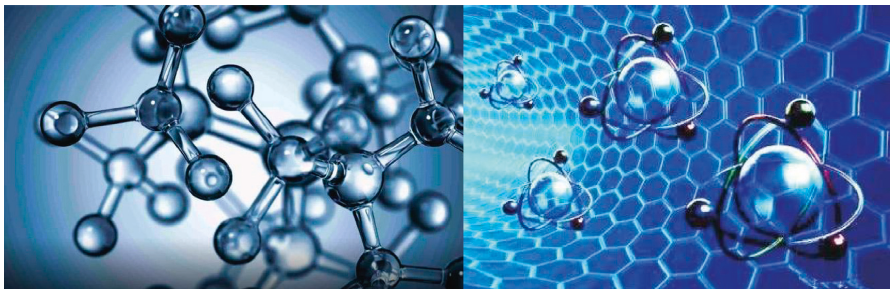
Figure 2: Nanoparticle